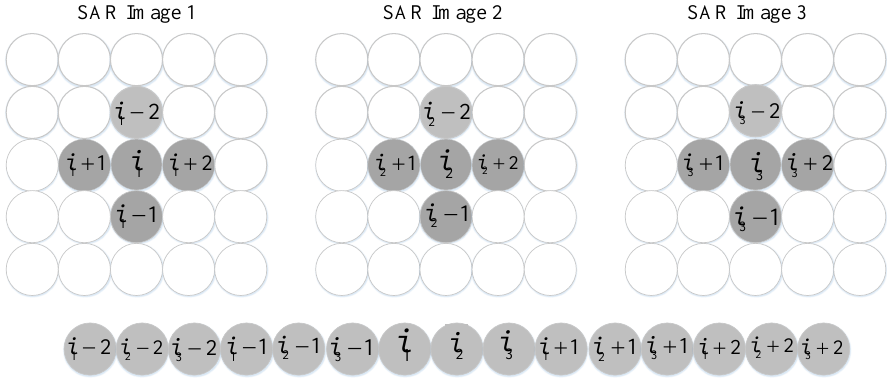
Figure 2. Formulation of joint data